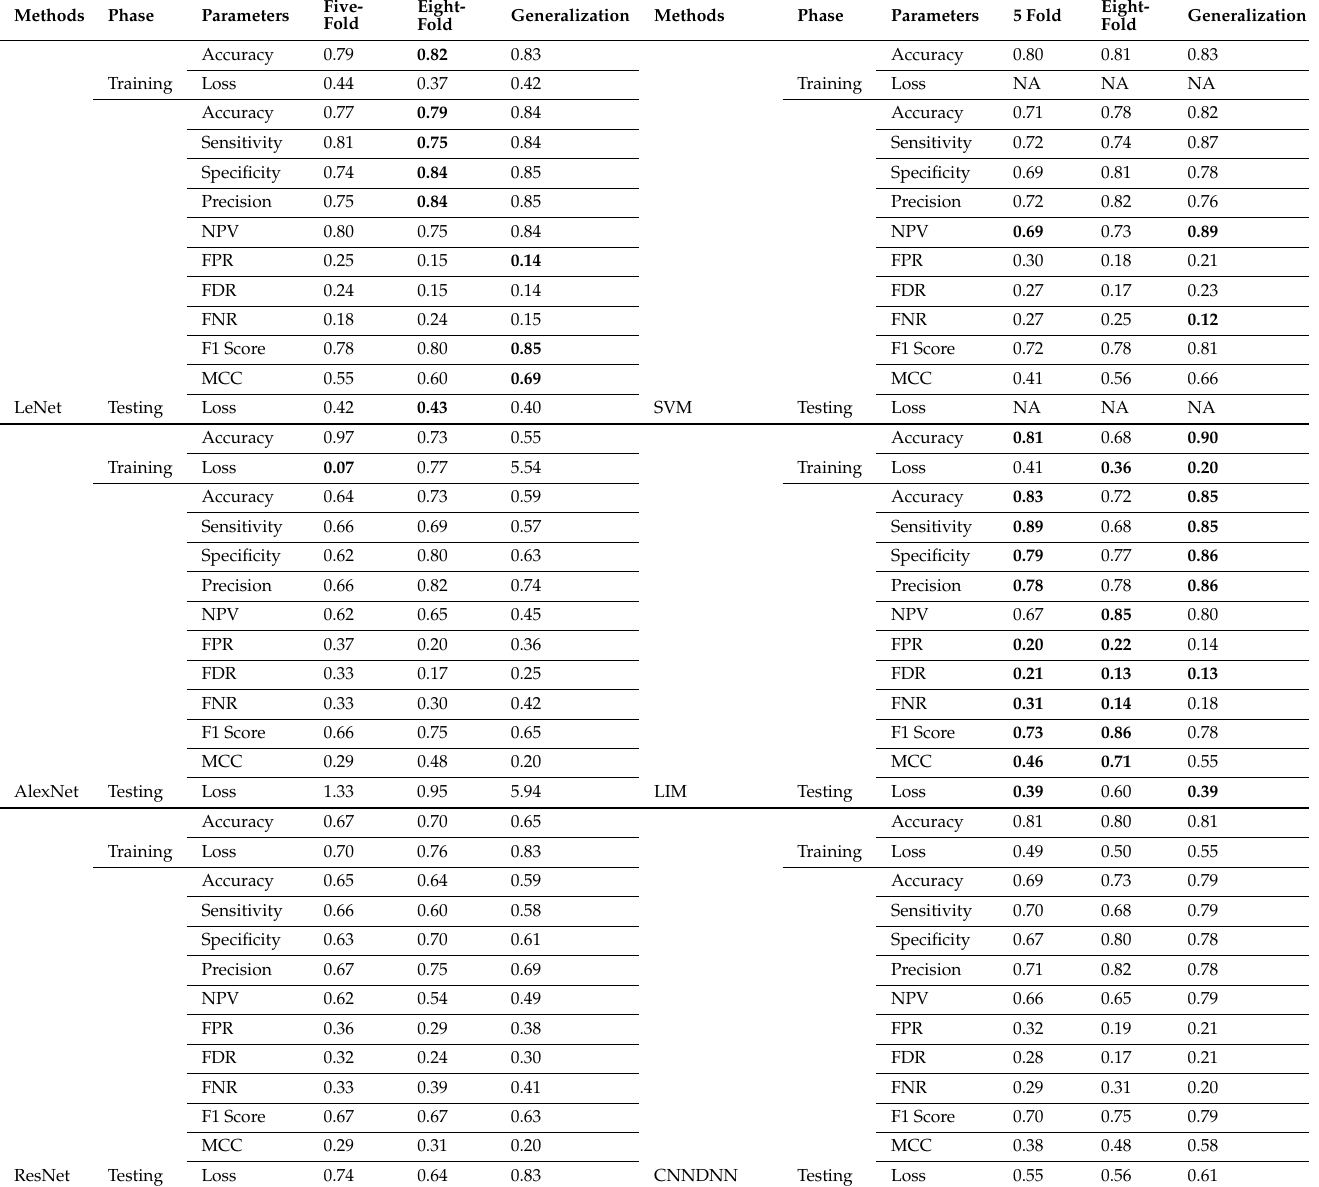
Table 4. Output obtained for LeNet, AlexNet, ResNet, SVM, LIM, and CNN-DNN for classification into normal or abnormal with best result highlighted in